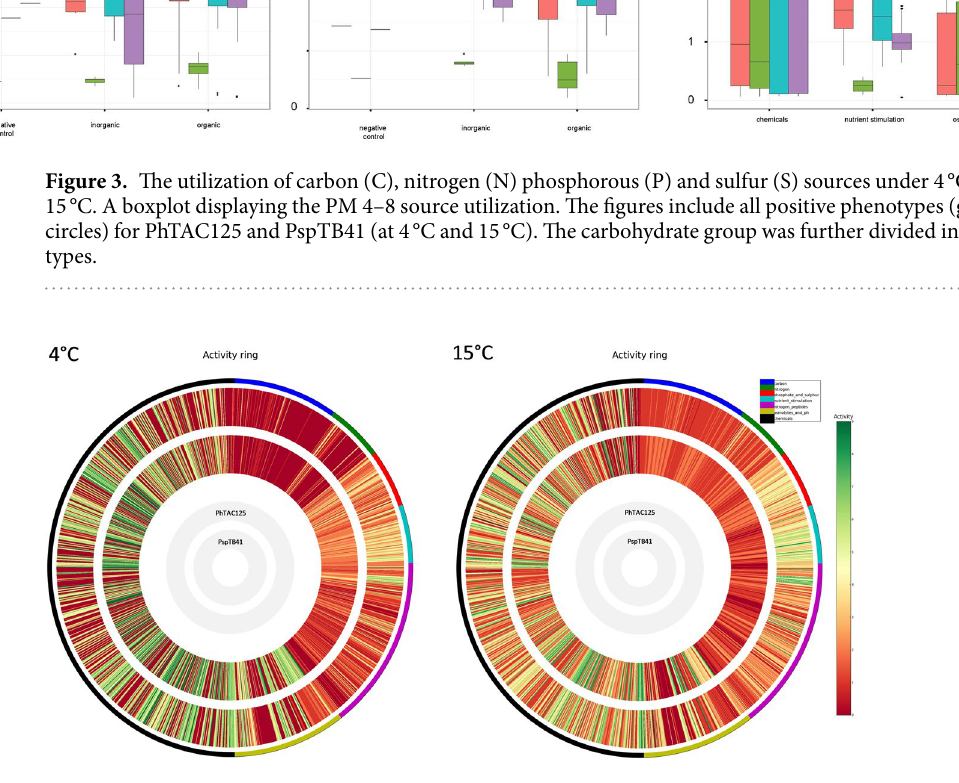
Figure 4. High-throughput metabolic activity of PhTAC125 and PspTB41 at 4 °C and 15 °C. The metabolic activity is expressed as AV value and colored from red (low activity) to green (high activity) and visualized through the DuctApe Activity rings, indicating the PM substrates differentially utilized by PhTAC125 and PspsTB41 at 4 °C and 15 °C. Circles display (from the outside): (1) the metabolic activity of PhTAC125 strain; (2) the metabolic activity of TB41 strain; the lane external to the circles is color-coded according to different functional PM categories: blue indicates Carbon sources (PM1,2); green indicates Nitrogen sources (PM3); red indicates Phosphate and Sulfure substrates (PM4); light blue indicates Nutrient Stimulation substrates (PM5); purple indicates Nitrogen Peptides (PM6,7,8); light green indicates Osmolytes and pH (PM9,10); black indicates Chemical compounds